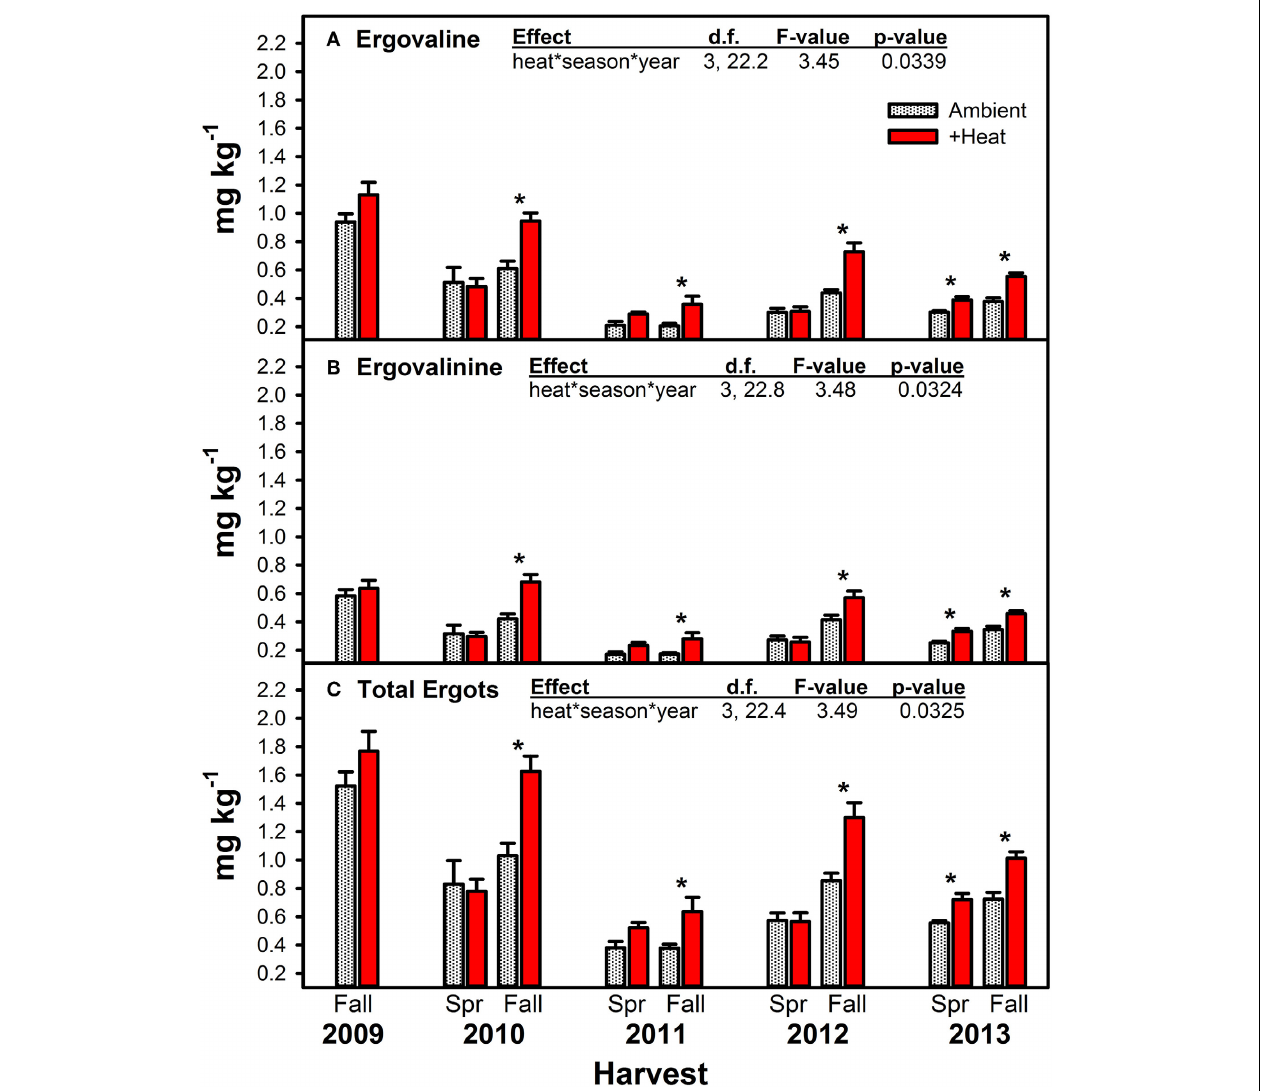
FIGURE 4 | Average ( ± SE) concentrations of ergovaline (A), ergovalinine (B), and the sum of these two ergot alkaloids (C) measured in endophyte-infected tall fescue tillers harvested from heated and non-heated, ambient temperature treatments in Spring and Fall of all